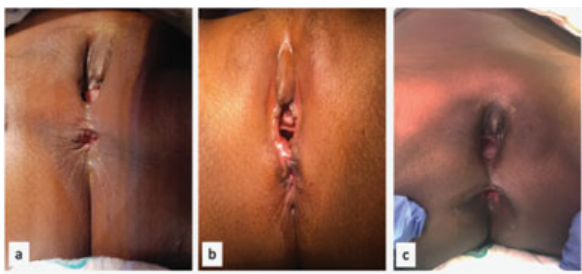
Fig. 2 The three perineal injuries at EUA after the perineal repair was performed. ( A ) Case 1; ( B ) case 2; ( C ) case 3. EUA, examination under